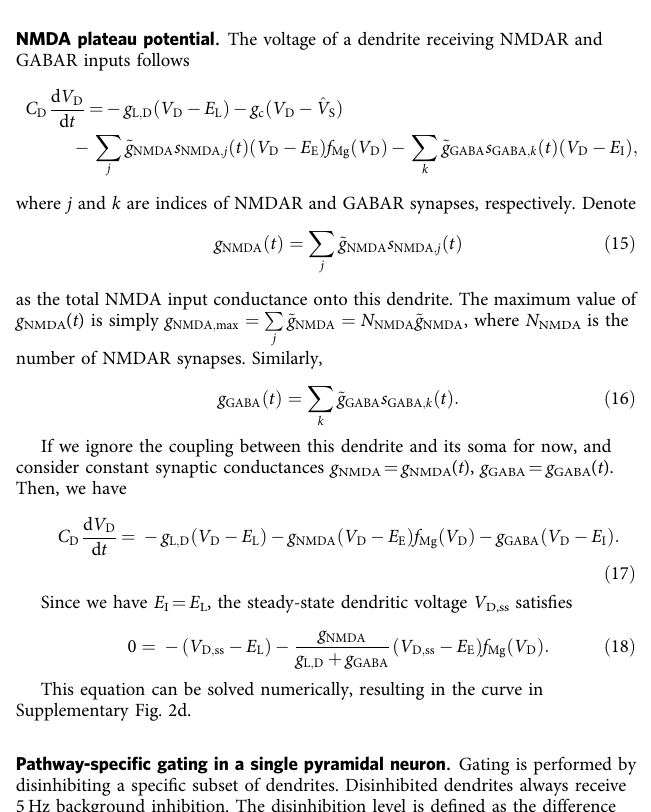
This increase of width b as a function of (cid:2) g I captures the linearization effect of sparse inhibition on the voltage input function (Fig. 2c). Fit values of the parameters are b g ¼ 5.56, k ¼ 9.64nS, g ¼ 6.54nS and V 0 ¼ 0.78mV. The model is fitted to a simulated 10-dendrite spiking neuron model. When simulating